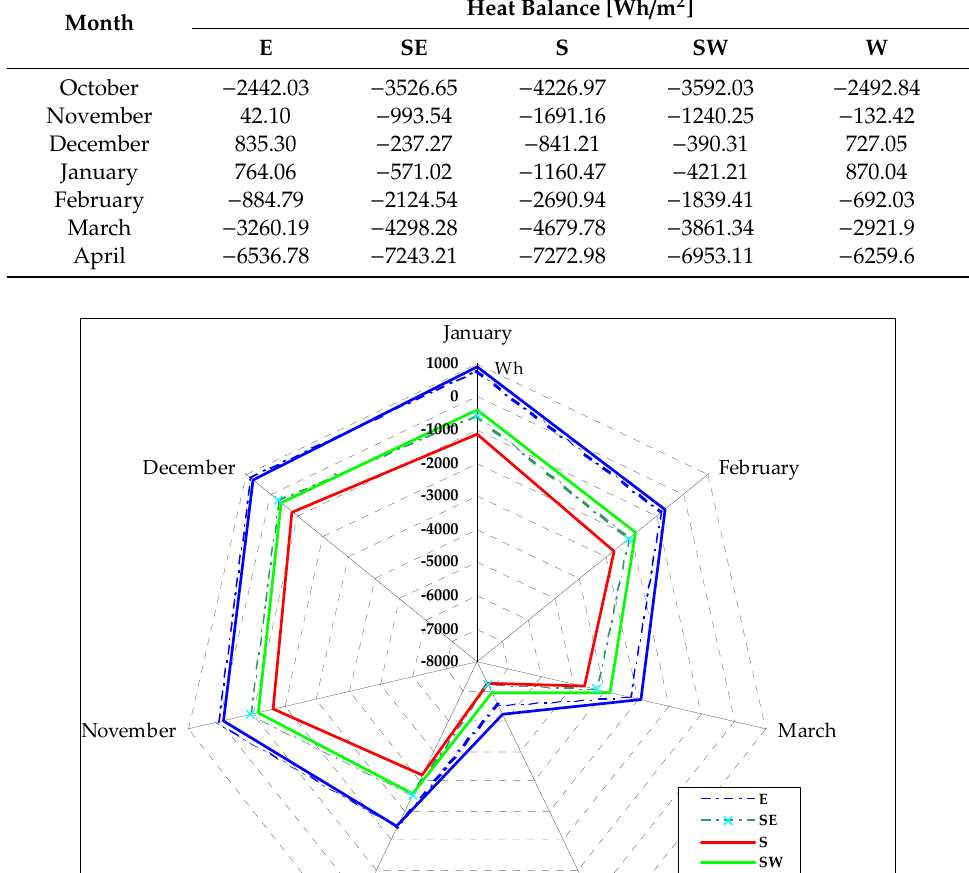
Figure 12. An example of heat flux density distribution on the IGW inner surface during a day. Depending on the daily sum of solar radiation the IGW inner surface generates a flux oriented towards the building interior even eight hours after the sunset. It should also be noted that the heat flux given up by the wall surface during the day did not exceed 40 W/m 2 . It is a value ten times lower